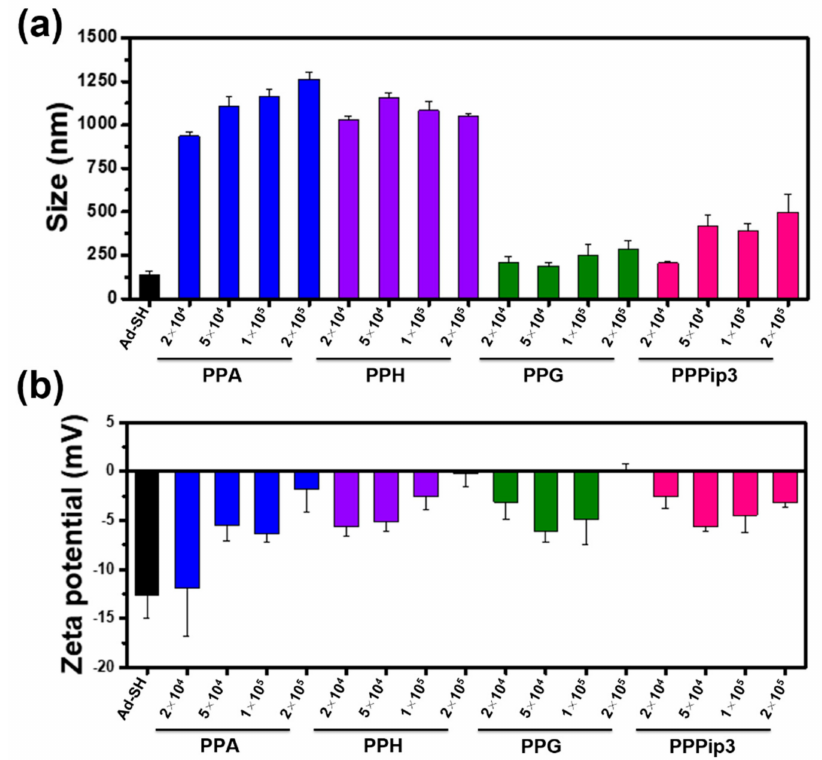
Figure 6. ( a ) Average size and ( b ) zeta potential of PAA-SPDP variants conjugated with Ad-SH. For conjugation, fixed amount of Ad-SH (5 × 10 9 vp) was reacted with various molar ratios of PPA-SPDP (2 × 10 4 , 5 × 10 4 , 1 × 10 5 , or 2 × 10 5 ) at pH 7.4. The error bars represent means ± SD of five